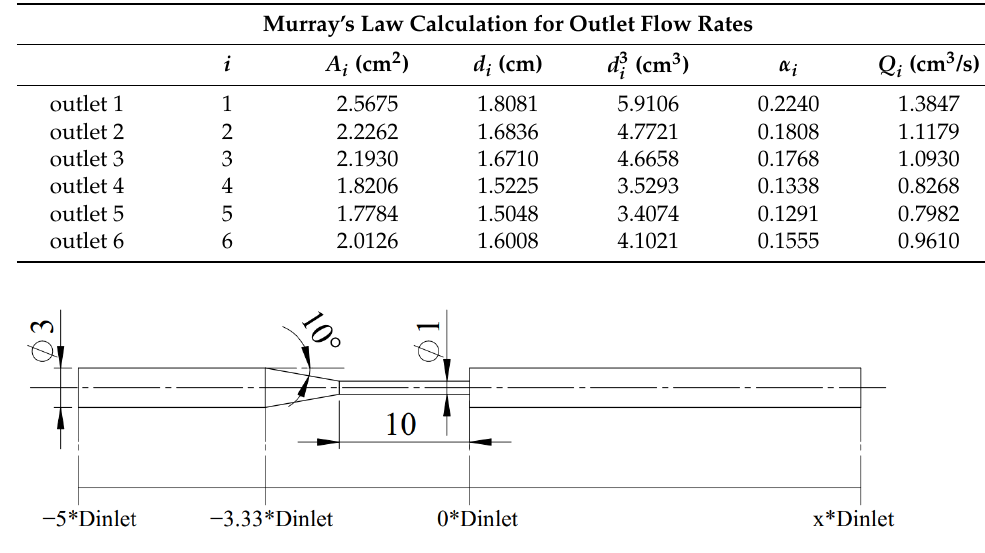
Figure 7. Geometry of coronary nozzle [18]. Table 8. Experimentally obtained input parameters for simulation of FDA nozzle [18].